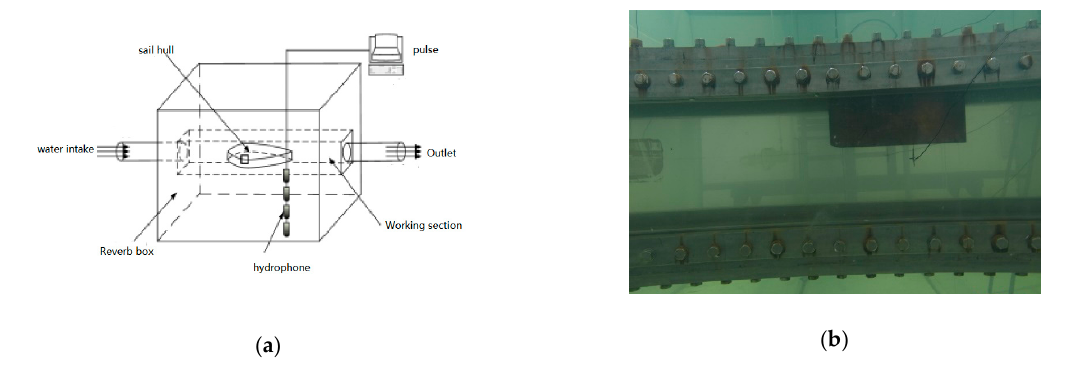
Figure 18. Diagram of the measurement. ( a ) Chart of the experimental test. The model is rigidly placed at the bottom of the working section, and the hydrodynamic noise from the model is excited by the water flow due to the gravity. A vertical array of several hydrophones is placed in the water tank outside the working section, which collects the hydrodynamic noise from the model. ( b ) Practical photo of the model.